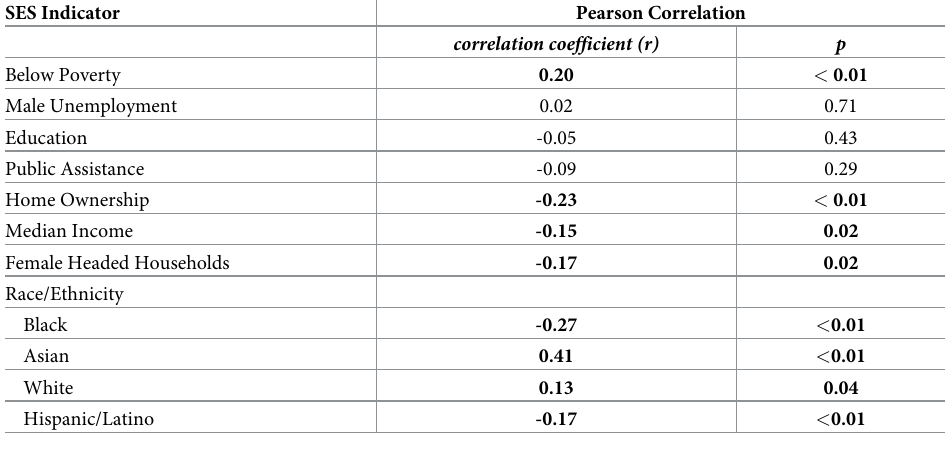
Table 2. Pearson correlations of SES indicators with average annual UFP exposure (2013) in Boston block groups within 1000 m of mobile monitoring route 1 .